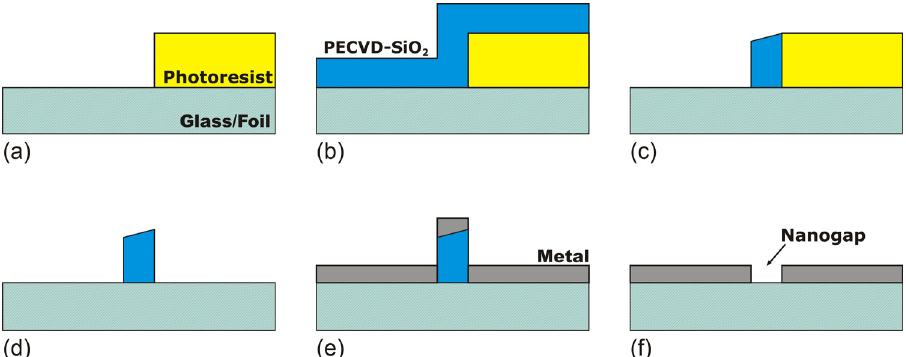
Figure 5. Process flow for integrating nanoscaled gaps on glass or foils. ( a ) The photoresist is structured by conventional photolithography. ( b ) A SiO 2 layer is deposited at low temperature and ( c ) etched anisotropically. ( d ) Subsequent to the photoresist removal, a nanoline stays back. ( e ) A metal is evaporated anisotroically and ( f ) the SiO2 is removed by a selective etching